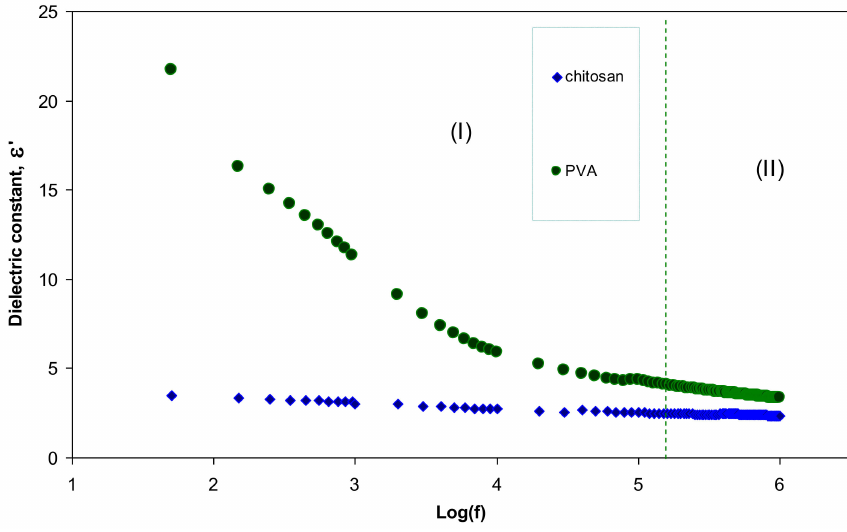
Figure 11. Dielectric constant versus frequency for pure PVA and pure CS.